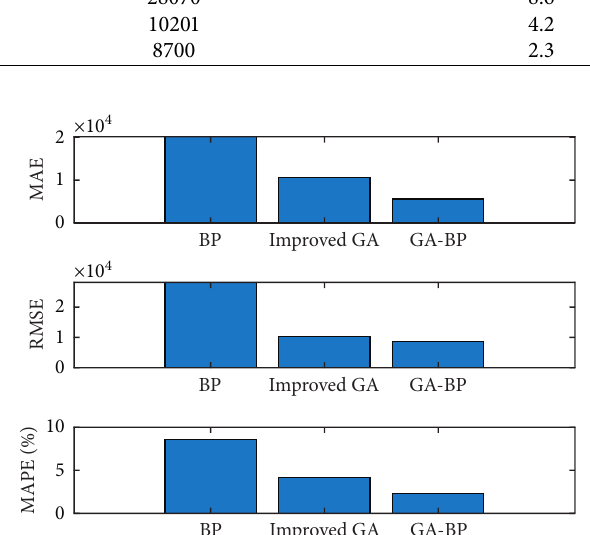
Figure 8: Prediction performances of three types of the prediction